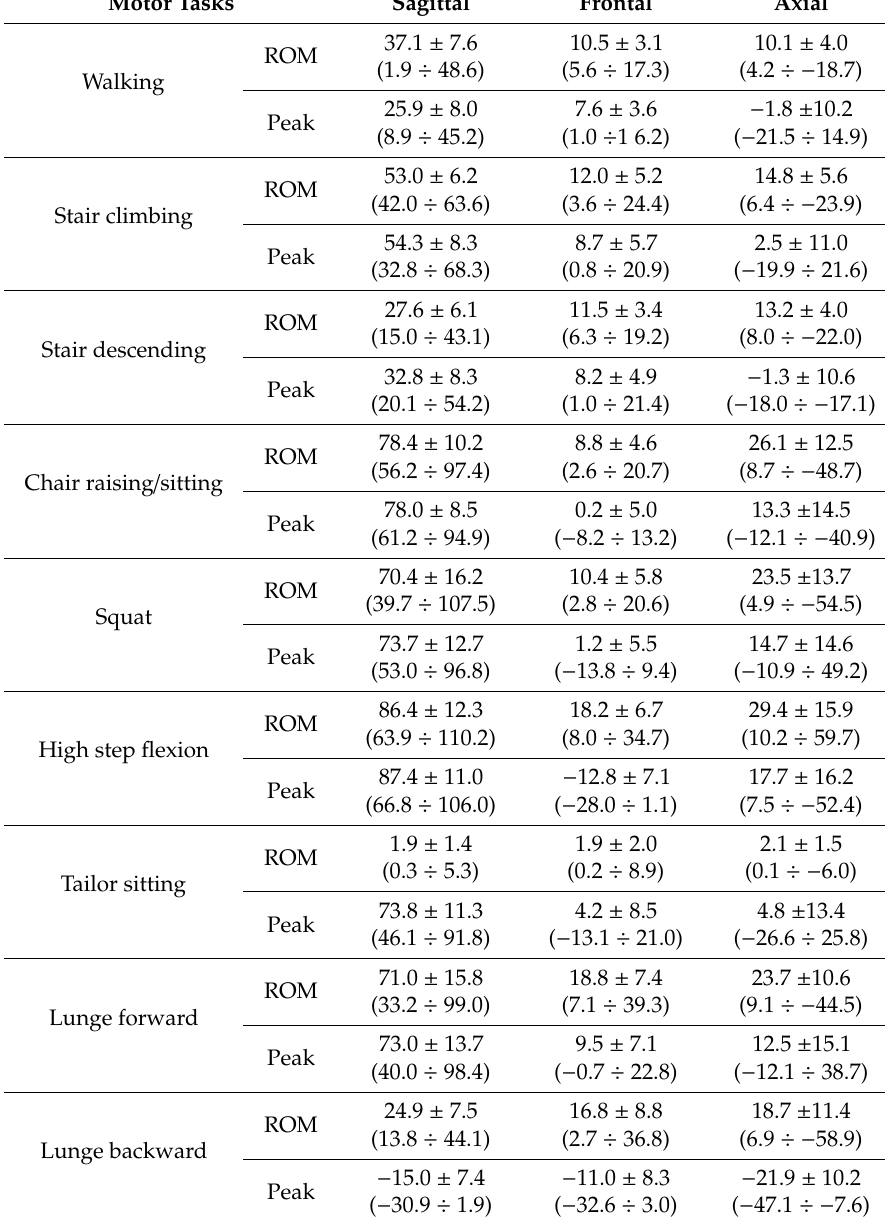
Table 2. Absolute range of motion (ROM, in ◦ ) and related peak values relative to the neutral joint alignment, i.e., 0 ◦ , for the three anatomical planes (columns) for each of the analyzed motor tasks in the GA; the mean ± standard deviation over the patients, along with a range of (min ÷ max) values, are